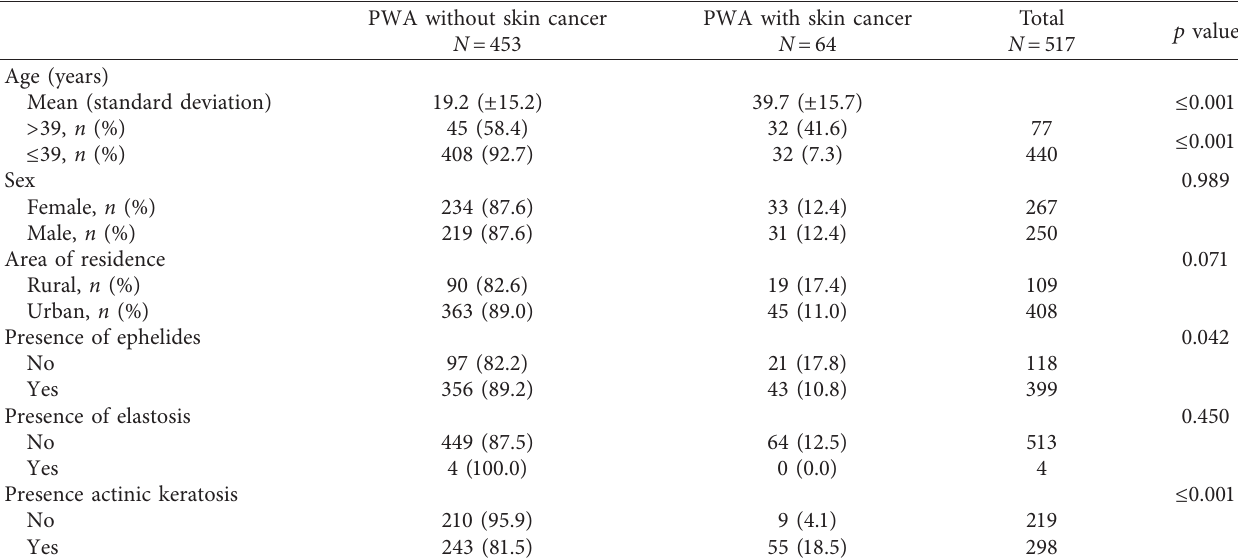
Table 2: Factors associated with skin cancer in univariate analysis.